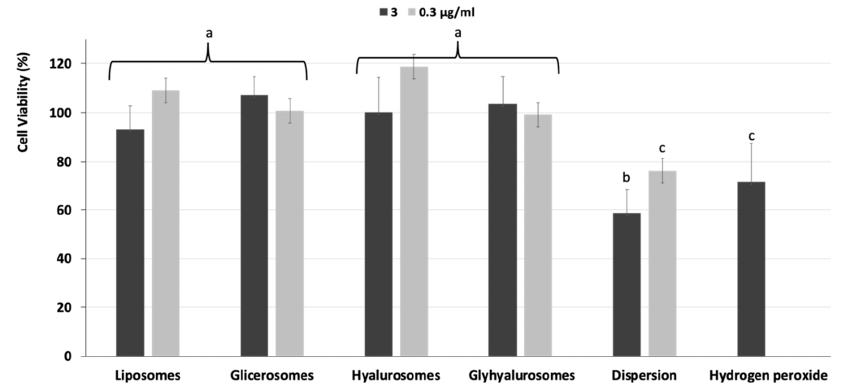
Figure 8. Viability of epithelial cells stressed with hydrogen peroxide and treated with ginger extract in dispersion or loaded in liposomes, glycerosomes, hyalurosomes and glyhyalurosomes. Data are reported as mean values ± standard deviation of cell viability expressed as the percentage of the negative control (100% viability). Each symbol (a, b, c) indicate the same